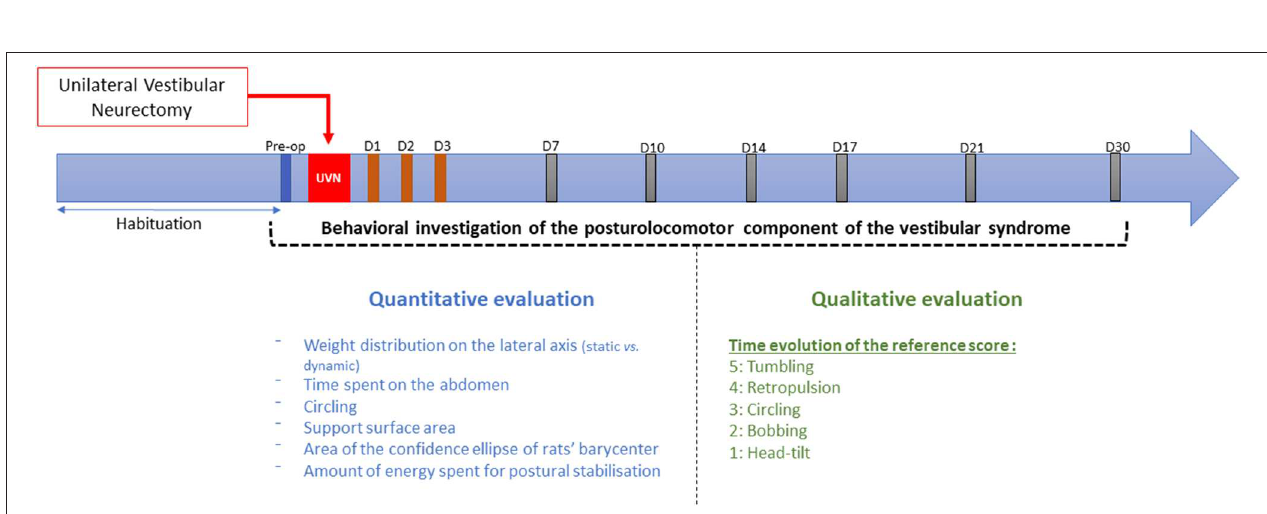
FIGURE 2 | Study design. Details of the procedure used to evaluate quantitatively and qualitatively the vestibular syndrome before and after unilateral vestibular neurectomy. Behavioral investigation of the posturolocomotor component of the vestibular syndrome was made in a first preoperative session (serving as a reference value) and then at 1, 2, 3, 7, 10, 14, 17, 21, and 30 post-lesioned days (D). Two types of evaluation were carried: a first quantitative evaluation detailed in this study and a qualitative evaluation based on previous paper (5).